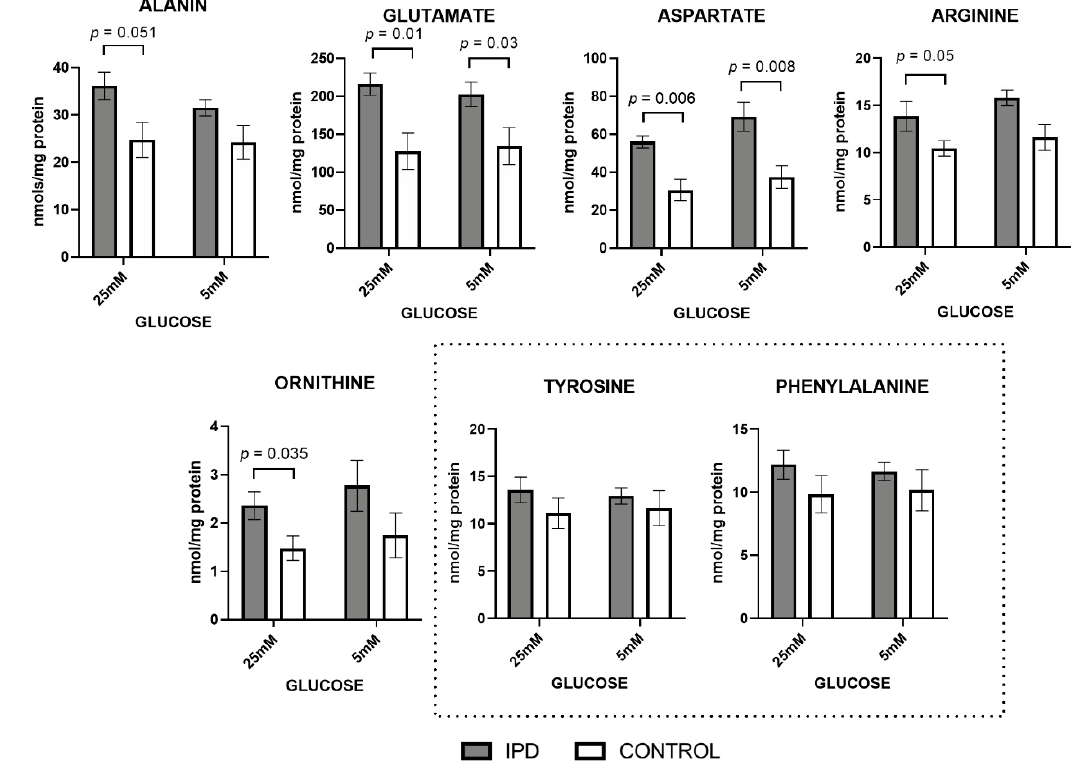
Figure 2. Amino acids levels in fibroblasts of iPD patients vs. controls exposed to low or high glucose concentration (5 vs. 25 mM). Levels of amino acids related to mitochondrial metabolism were increased in fibroblasts from idiopathic Parkinson’s disease patients (iPD, grey bars) vs. controls (C, white bars), especially in high glucose exposition. As technical controls, amino acids not related to mitochondrial metabolism (such as tyrosine or phenylalanine) were measured and found to be conserved among iPD patients, controls, and glucose concentrations, suggesting that only mitochondrial-related amino acids were affected.